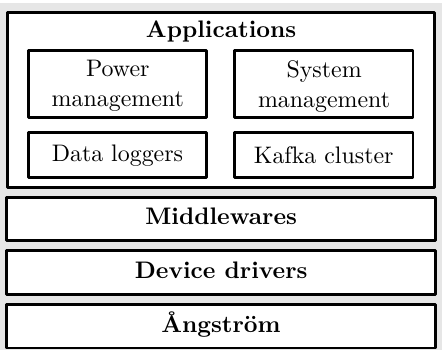
Figure 7. The custom Board Support Package (BSP) contains four areas of applications running on an operating system called Ångström: system management, power management, data cluster, and data